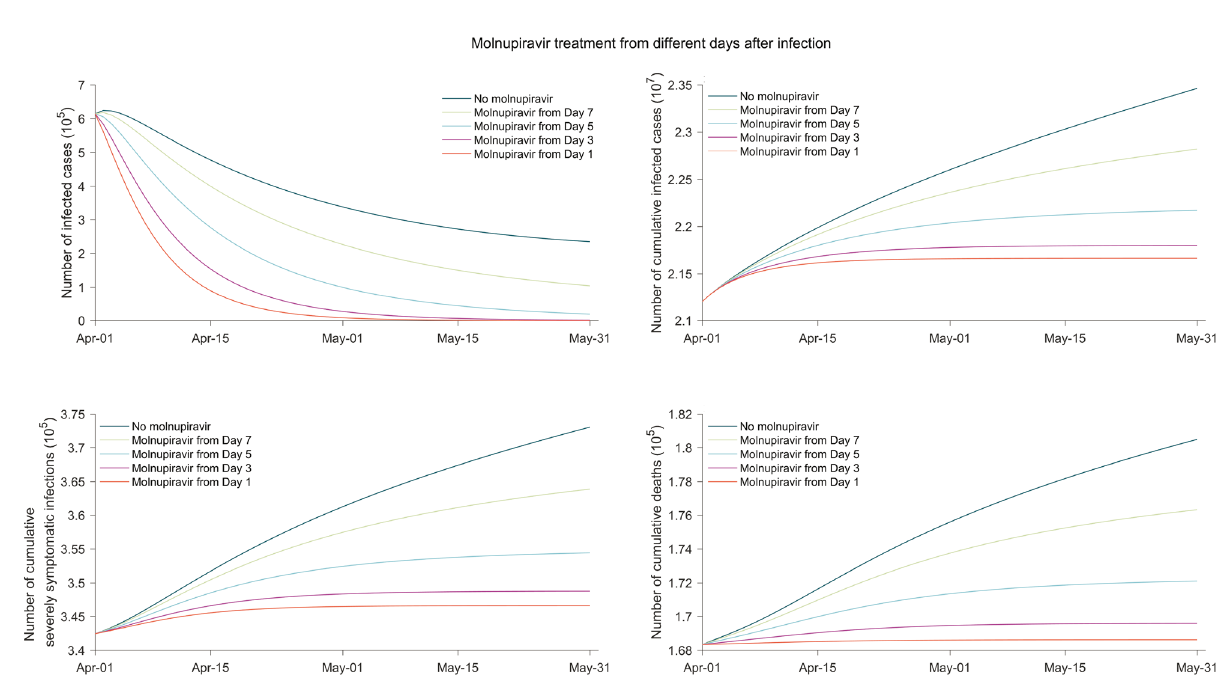
Figure 7. The impact of the timeliness of applying molnupiravir treatment in the setting of UK. In this scenario, all nonhospitalized cases are proportionally treated with molnupiravir. The timeliness is referring to molnupiravir treatment starting on which day post-infection. The settings of social activity level, the reinfection proportion, dominating pango lineages, and the molnupiravir treatment effectiveness for individuals are identical to those in Fig.